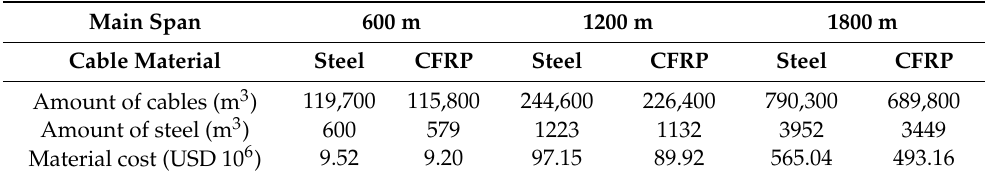
Table 6. Material amount and cost of